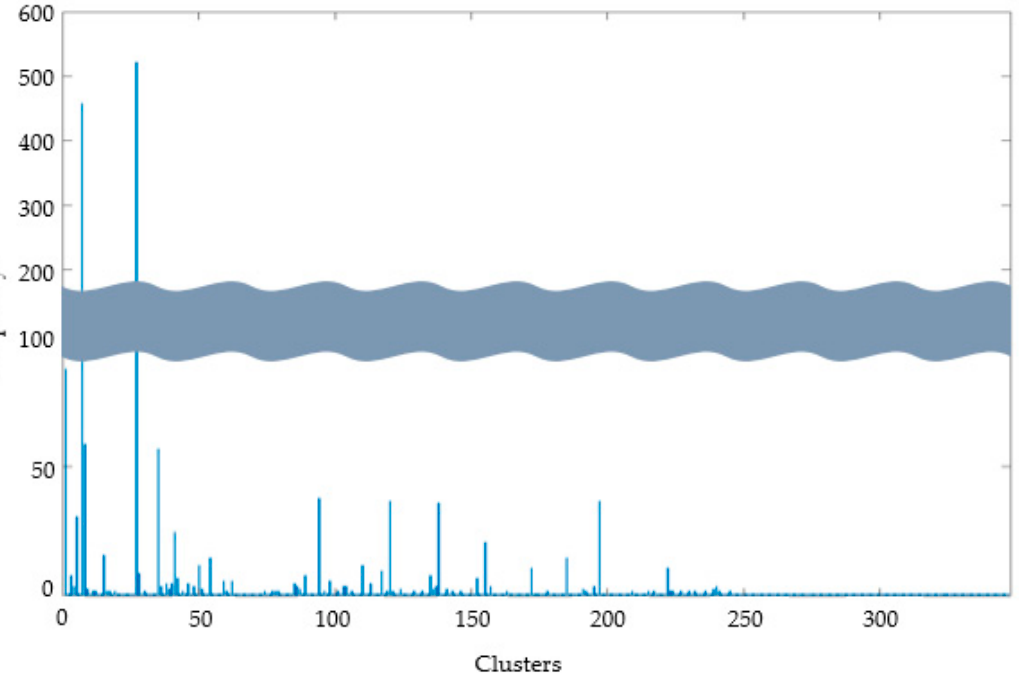
Figure 13. Clustering of 1:1 vessels and similar navigation situations: ( a ) a cluster group with a hamming distance of less than 2.3 from a 1:1 situation, ( b ) a cluster group with a hamming dis- tance of larger than 2.3 from 1:1 situation. Figure 14 shows the conversion of the hamming distance to the number of different input elements. This figure shows that the clusters can be distinguished into two large